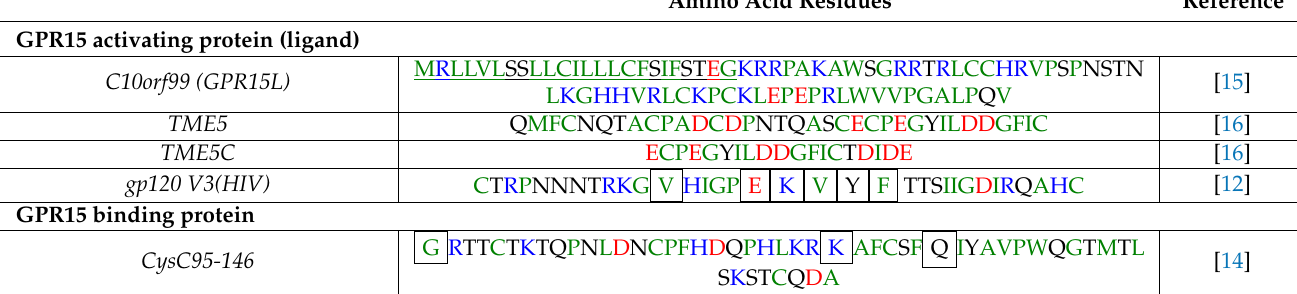
Table 1. Sequences of GPR15-interacting proteins/peptides. Color code for amino acid residues: green, hydrophobic uncharged; red, acidic; blue, basic; black, other; underline, signal peptide; black boxes, residues essential for binding to GPR15; bluish colored background, cysteine